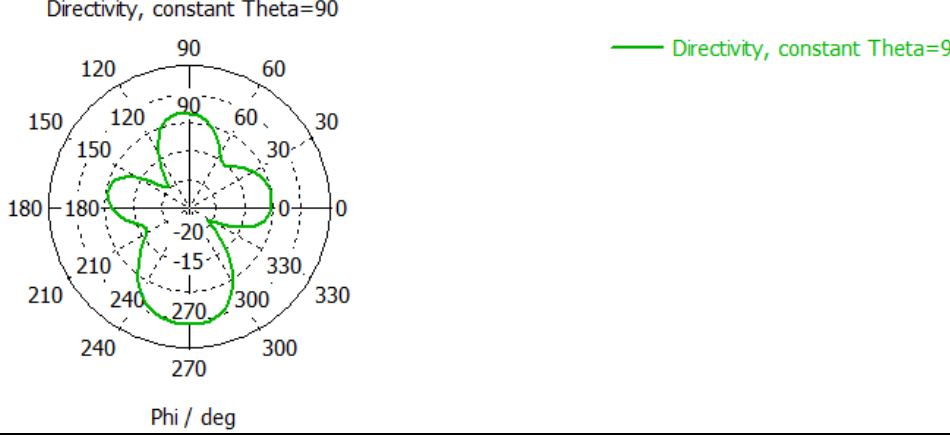
Figure 10. Directivity Performance Graph